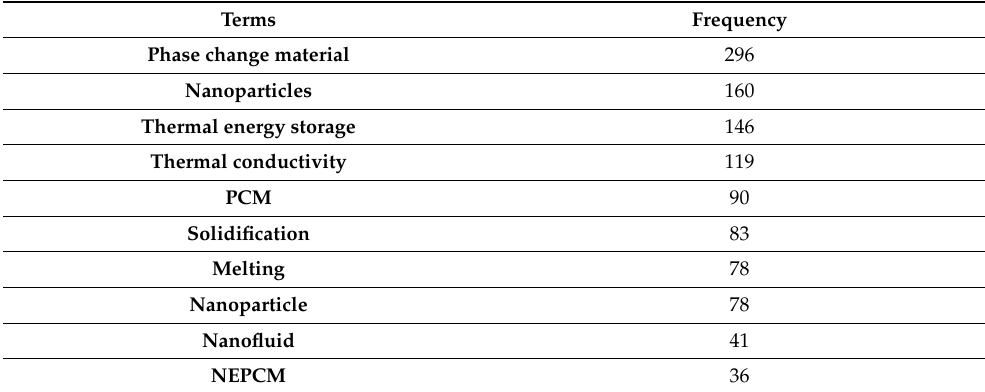
Table 1. Wordcloud of author’s keywords with over 35